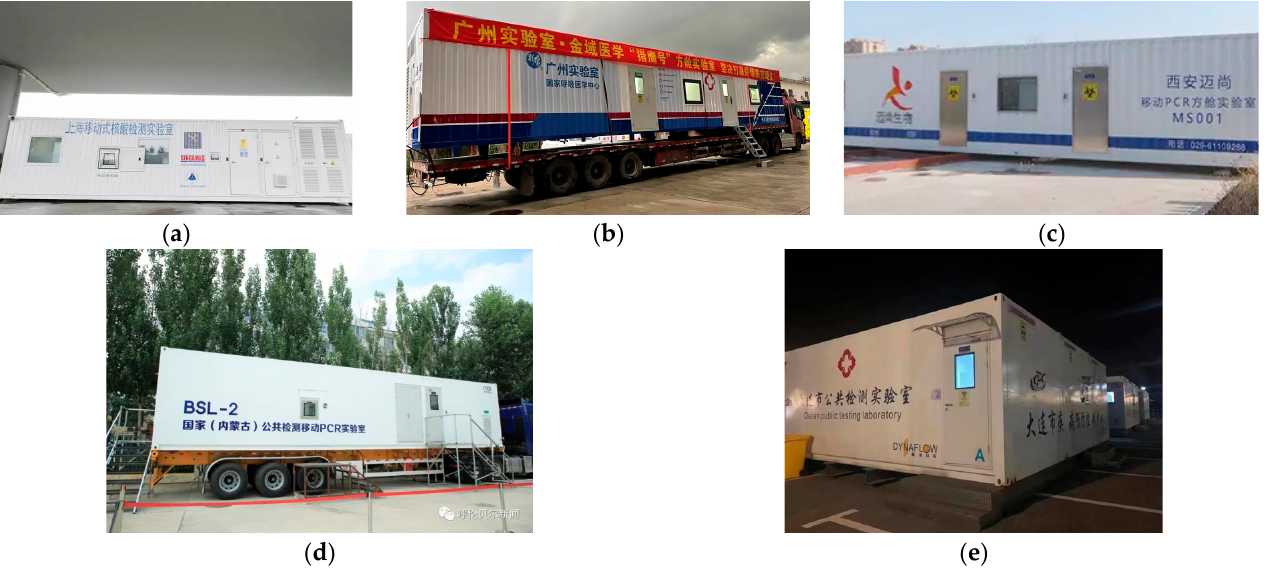
Figure 1. Shelter hospital/nuclein detection points in container carriers deployed in ( a ) Shanghai; ( b ) Guangzhou; ( c ) Xi’an; ( d ) Hohohot; ( e ) Dalian.